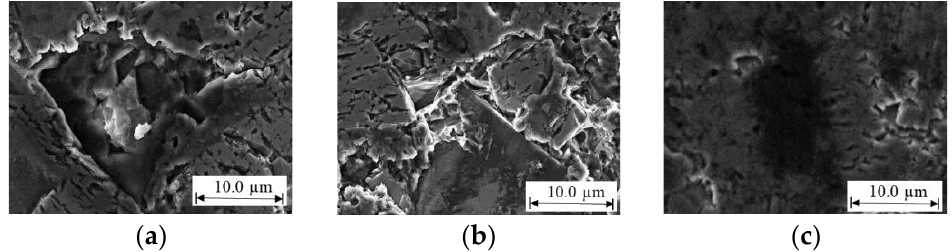
Figure 2. Major removal methods and morphologies of SiC particles. ( a ) Extraction of SiC particles, ( b ) fragmentation of SiC particles, and ( c ) cutting of SiC particles.